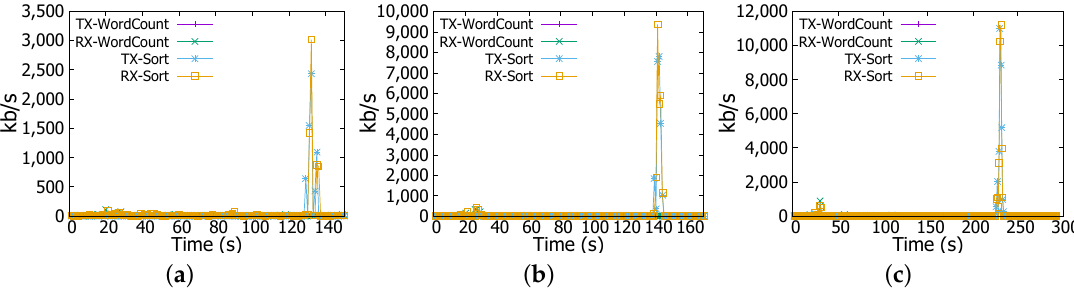
Figure 6. Network transmission (TX) and reception (RX) rates. ( a ) 1 GB file; ( b ) 4 GB file; ( c ) 6 GB